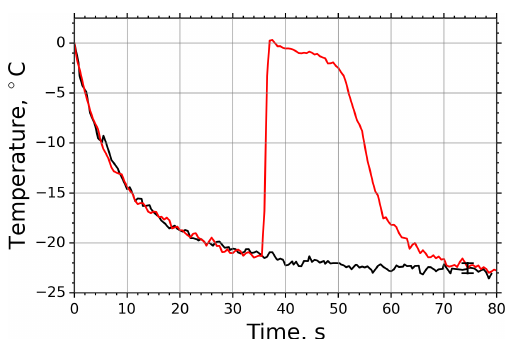
Figure 5. INAS density for kaolinite as a function of temperature determined from the frozen fraction of 0.1 and 1.0gL − 1 suspen- sion drops (marked with light and dark blue, respectively) inves- tigated in the M-WT. Each data point represents 70 individually measured droplets, each of which with diameter of approximately 700µm. The error bars represent the 1 σ values of the measured air temperatures and the calculated drop